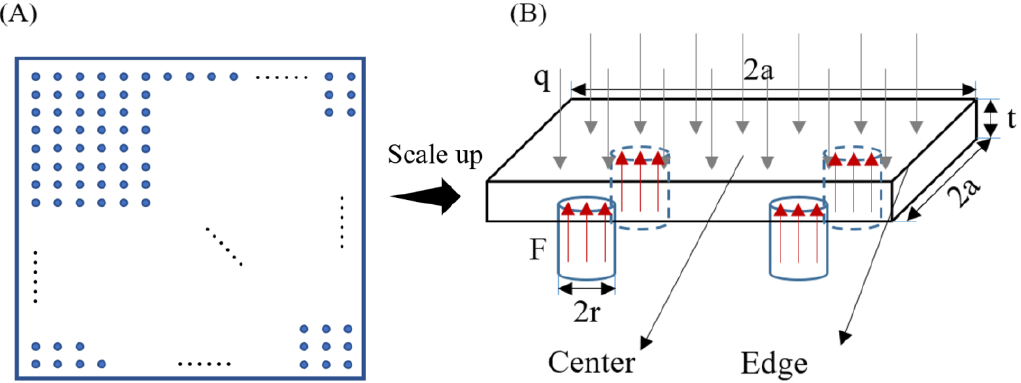
Figure 2. Outline of the mechanical analysis of the VIP, ( A ) plan and ( B ) element analysis.